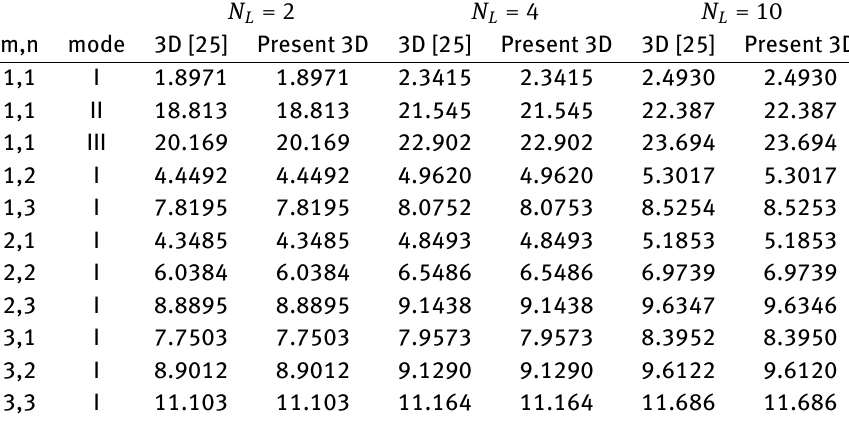
Table 3: Third assessment for the 3D exact solution, simply supported composite cylindrical panel with thickness ratio R α / h = 20 . Circular